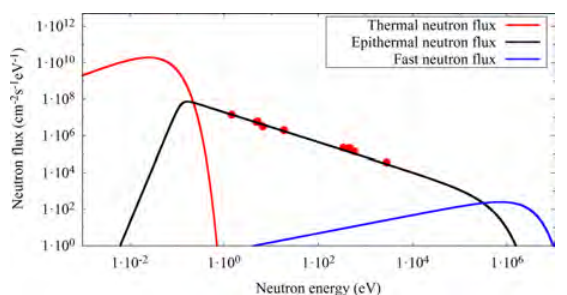
Figure 6. Analytic description of neutron flux regions.